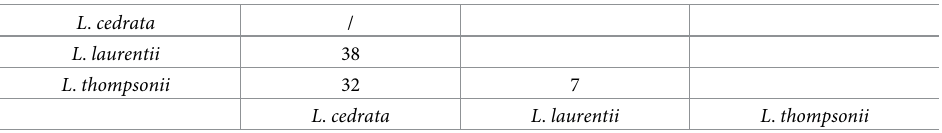
Table 13. SNPs variations in the ITS (ITS1 & ITS2) region among Leplaea species. L . cedrata